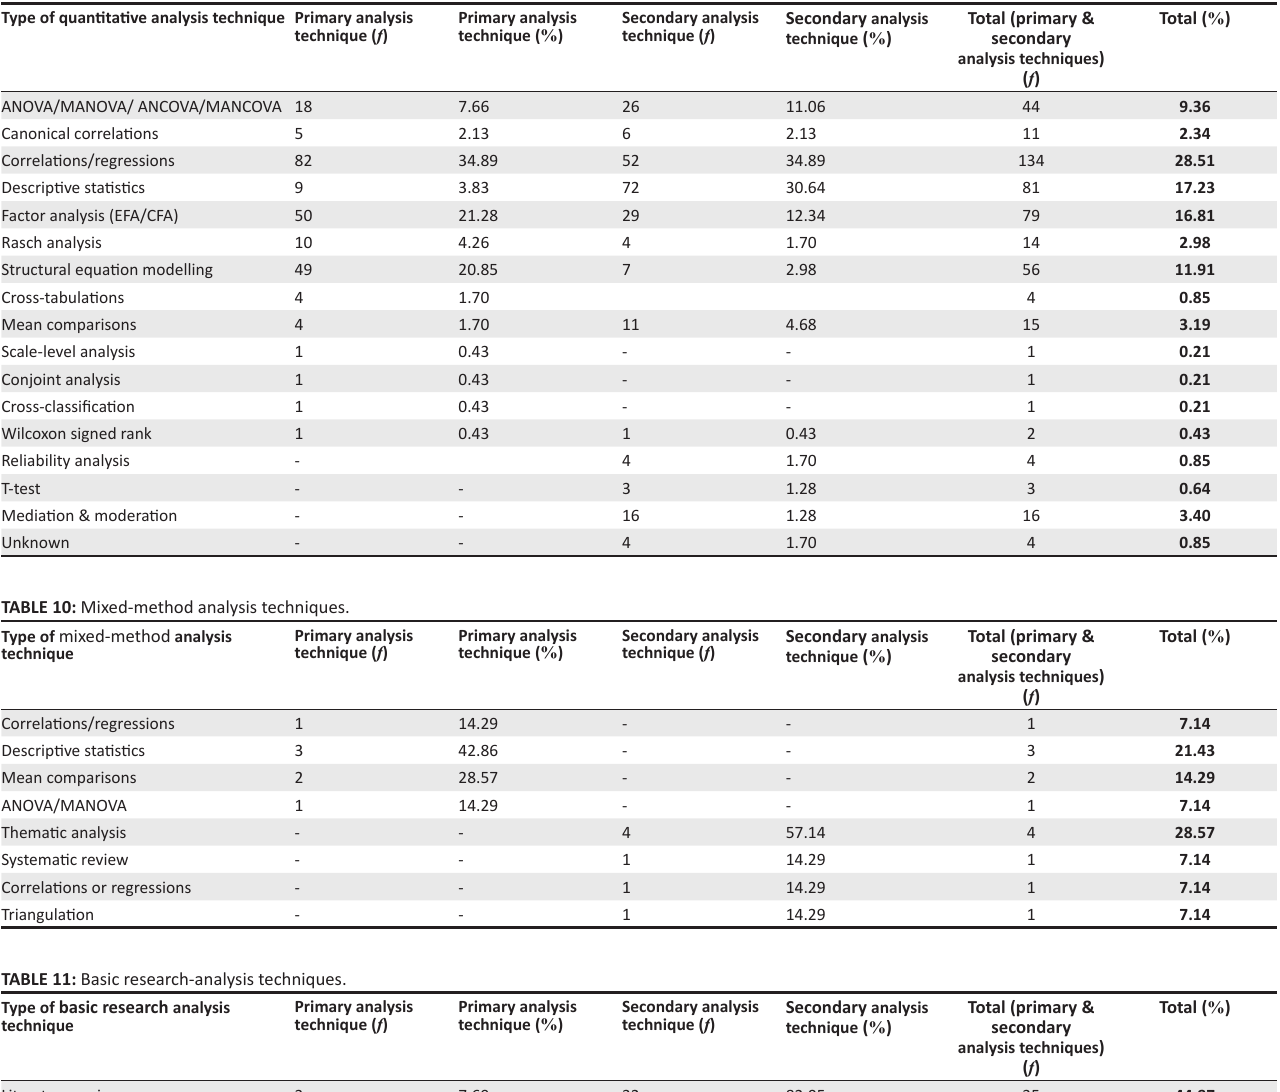
TABLE 9: Quantitative analysis techniques.